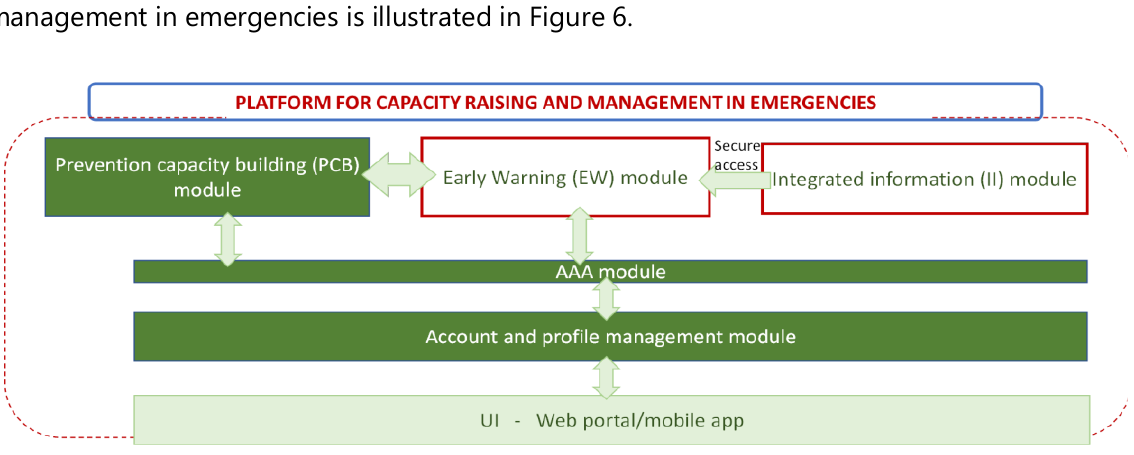
Figure 6: Platform for Capacity Raising in Emergencies - Basic Components (Source: Authors’